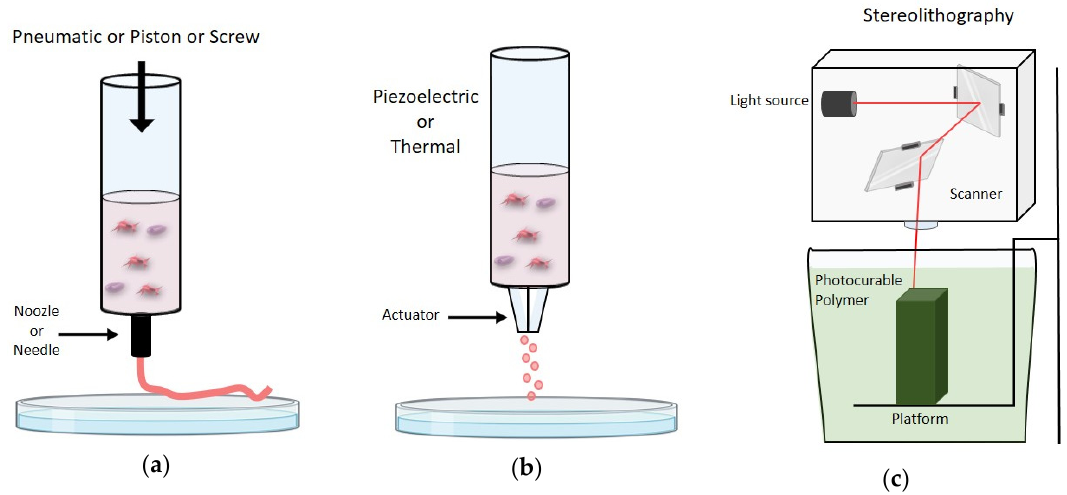
Figure 4. ( a ) Schematic representation of extrusion based bioprinting; ( b ) schematic representation of ink-jet based bioprinting; ( c ) schematic representation of light based